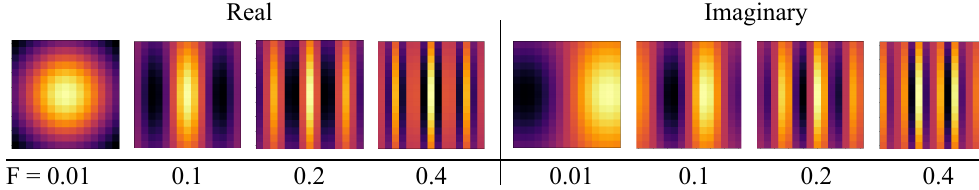
Figure 4. Gabor filters. Real and Imaginary parts of the Gabor filter ensemble for different frequencies using Equations (4) and (5) with σ x = 2, σ y = 2, ϕ =